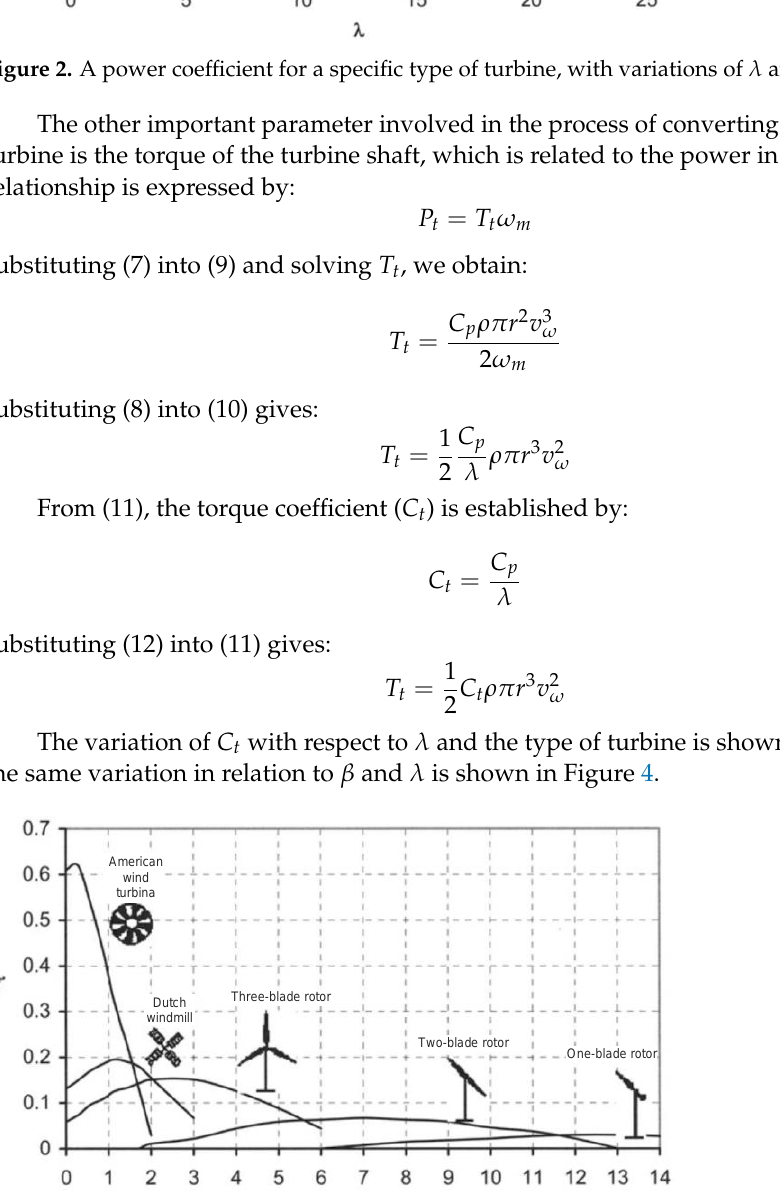
Figure 3. Torque coefficient that depends on λ and the type of wind turbine [17].